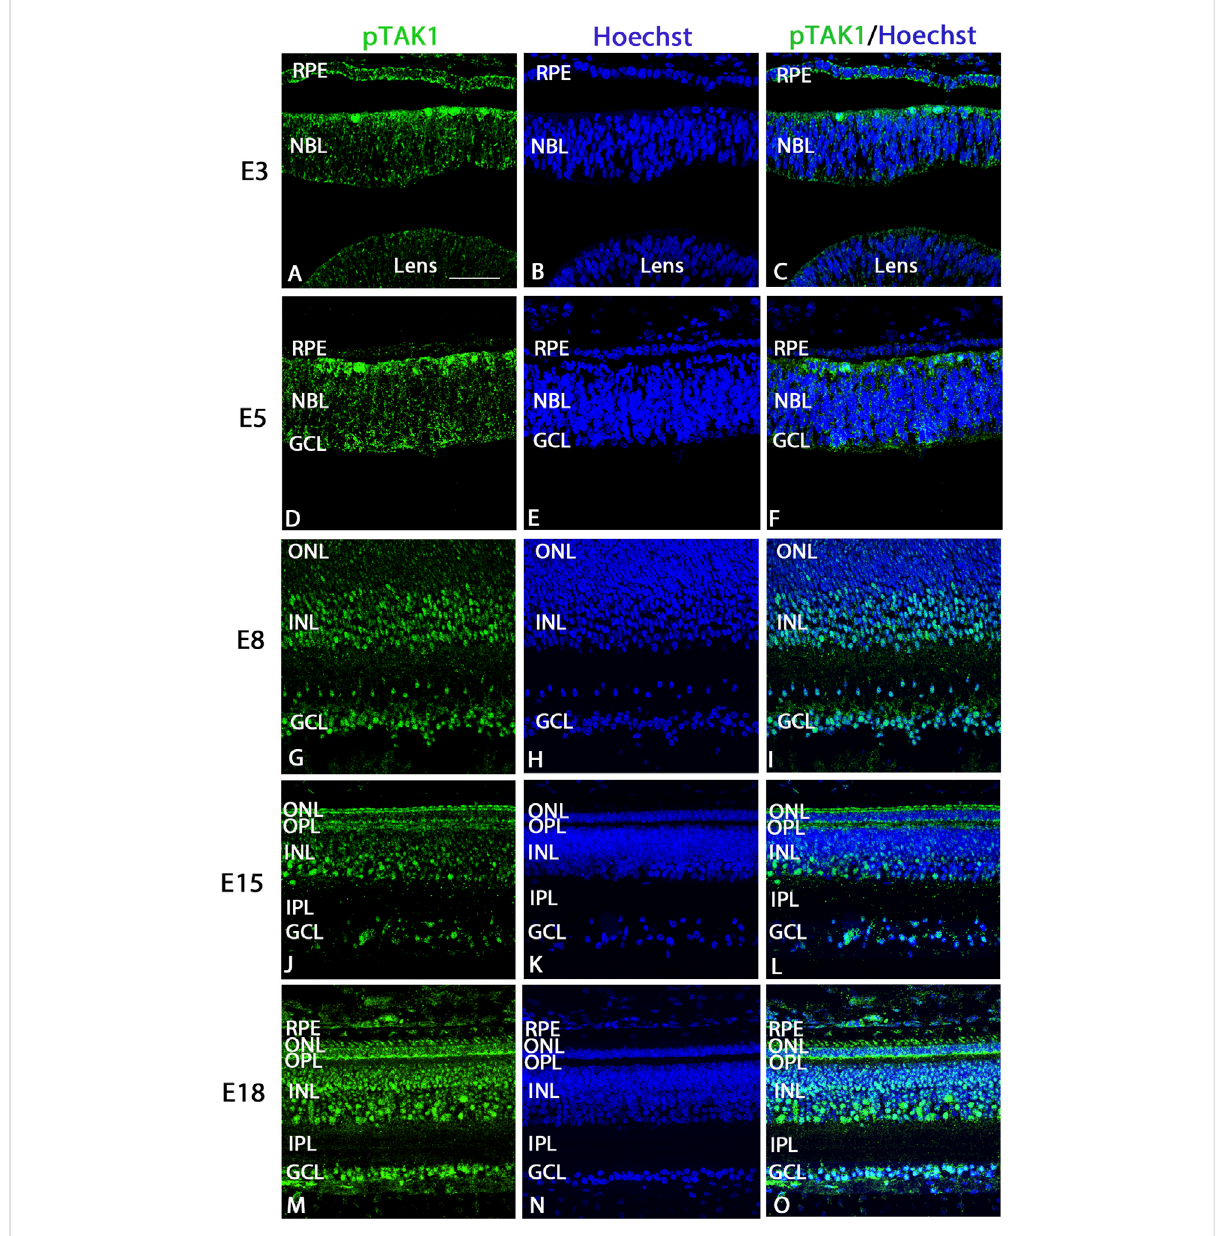
Phosphorylated TAK1 (pTAK1) weakly labels progenitor cells and heavily labels dividing and differentiating cells of the developing retina. Retinal sections fromE3,E5,E8, E15,andE18chick embryoswereco-labeledforpTAK1 (A,D,G,J,M) andHoechstnuclearstain (B,E,H,K,N) .Overlapinlabels is shown in (C,F,I,L,O) . Abbreviations: RPE, retinal pigmented epithelium; NBL, neuroblast layer; INL, inner nuclear layer; GCL, ganglion cell layer; OPL, outer plexiform layer; IPL, inner plexiform layer. Scale bar in A = 50 μ m for images (A – O)